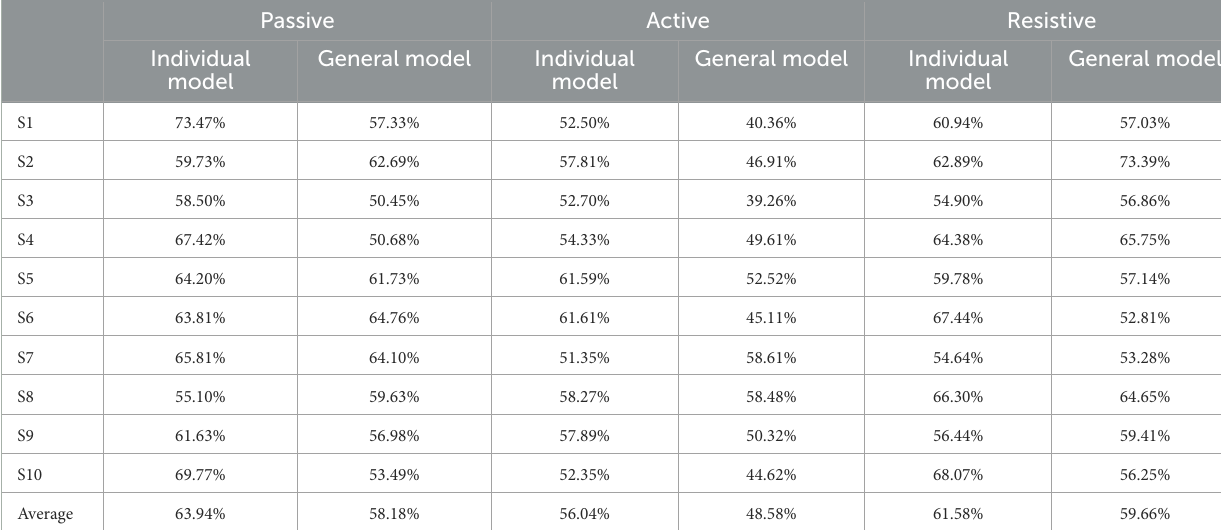
TABLE 5 The classification accuracy of different models for 10 participants in three training